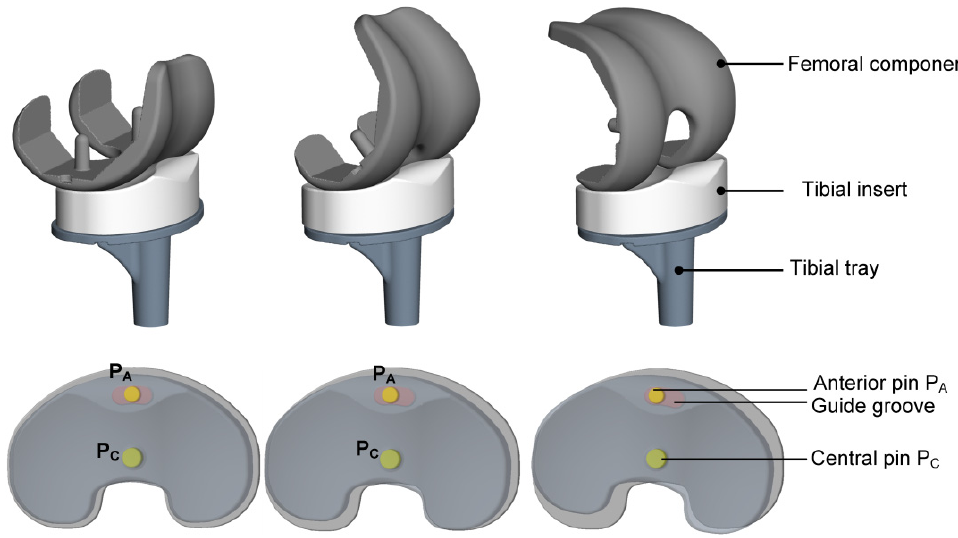
Figure 1. Exemplary movement of the commercially available mobile-bearing total knee replacement design (Columbus ® uniaxially rotating platform total knee replacement) during the squat motion.